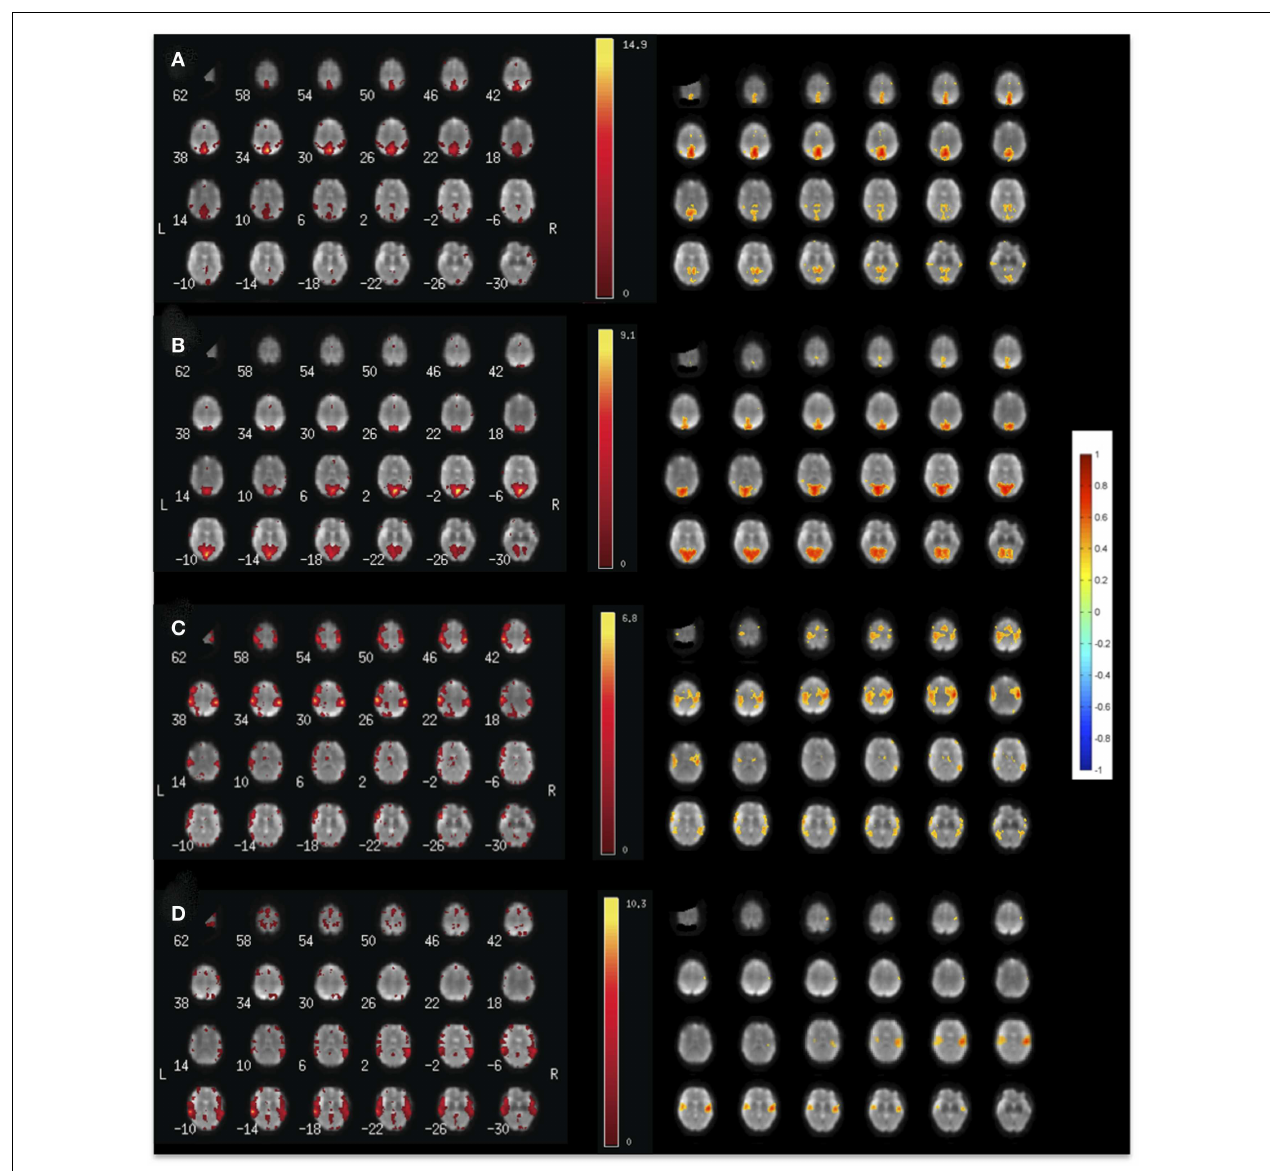
FIGURE 4 | Comparison of (left) ICA and (right) seed-based connectivity in a single subject for mapping (A) the default mode RSN, (B) the visual RSN, (C) the sensorimotor RSN, and (D) the auditory using MEVI2 atTR: 136ms .